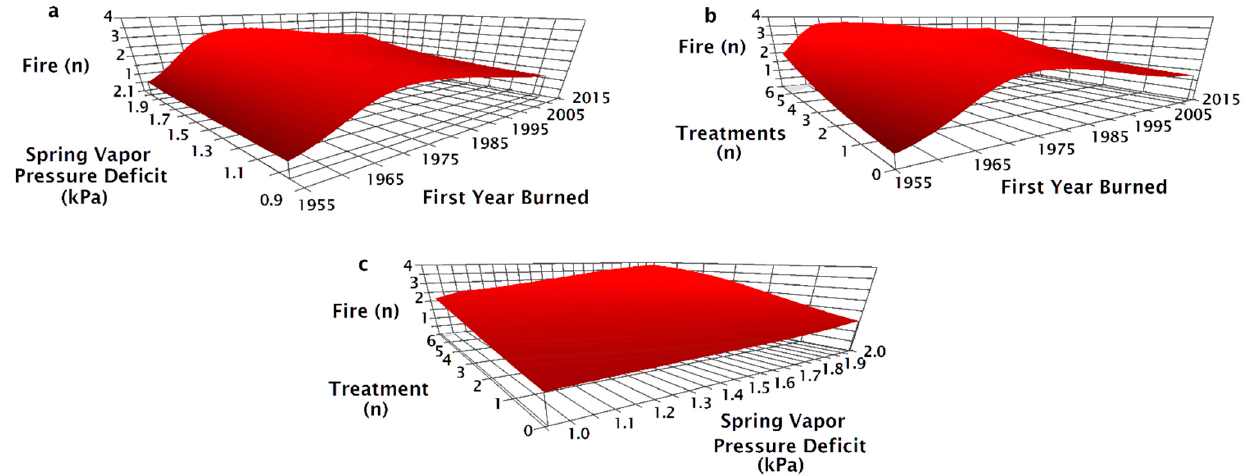
Figure 3. The Nonparametric Multiplicative Regression modeled relationship response of the number of fires to ( a ) the first year the site experienced fire and the 30-year average minimum vapor pressure deficit in spring (spring VPD), ( b ) the first year the location experienced a fire, and the total number of seed treatments, and ( c ) the 30-year average minimum vapor pressure deficit in spring and the total number of seed treatments. The color scale ranges from 0 fires (black) to 4 fires (red). Table 2. The Nonparametric Multiplicative Regression best-fit models for each fire regime variable. The explanatory var- iables that compose the models include the first year a site burned (1st fire year), the 30-year mean minimum vapor pres- sure deficit from March-May (Spring VPD min), the seeding treatment before the most recent fire (Pre-fire seeding treat), the total number of times a site was aerially seeded (Aerial seeding (n)), the total number of times a site was drill seeded (Drill seeding (n)) and 30-year mean spring precipitation from March-May (Spring precipitation).